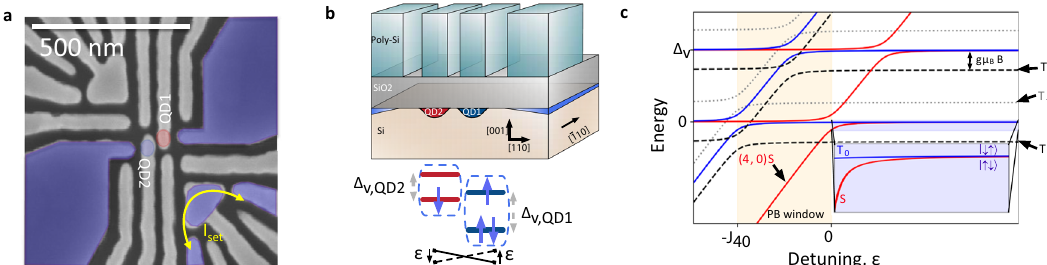
Fig. 1 MOS DQD singlet – triplet qubit device. a Scanning electron micrograph of the gate structure of a device similar to that measured. The shaded regions indicate estimated areas of electron accumulation. The red and blue circles represent the locations of QD1 and QD2, respectively. We sense QD charge state transitions using a nearby single electron transistor (SET) in the lower right corner. b Schematic lateral view of the device structure and representation of the electron spin fi lling in each QD. Δ v,QD1(QD2) is the valley splitting in QD1 (QD2) and ϵ is the QD-QD detuning. c Energy level diagram of the singlet – triplet system in the DQD. Δ v is the valley splitting and g μ B B is the electronic Zeeman splitting, where g is the electron g-factor, μ B is the Bohr magneton and B is the applied external magnetic fi eld. The orange region represents the Pauli blockade window, with the singlet – triplet splitting in the (N QD1 ,N QD2 ) = (4,0) charge region denoted by J 40 . (inset) Energy level diagram of the m = 0 qubit subspace in the (N QD1 ,N QD2 ) = (3,1) charge region.